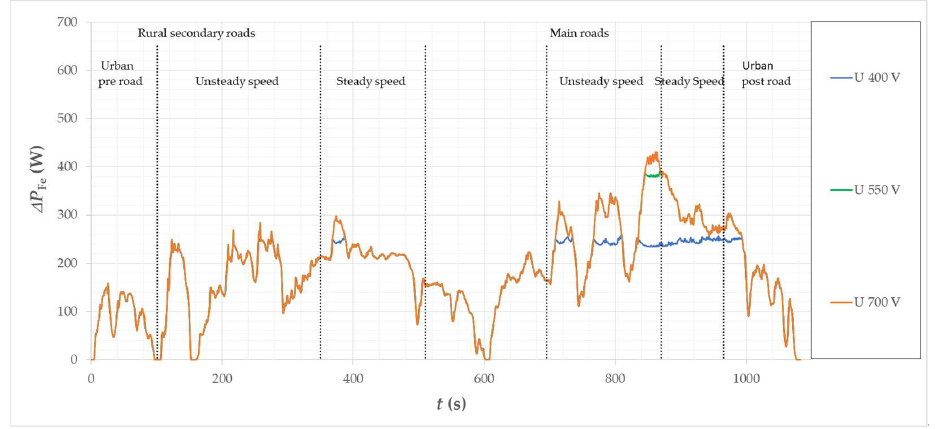
Figure 25. Calculated loss waveforms in the magnetic core of the motor for the considered vehicle in the Artemis Road driving cycle .